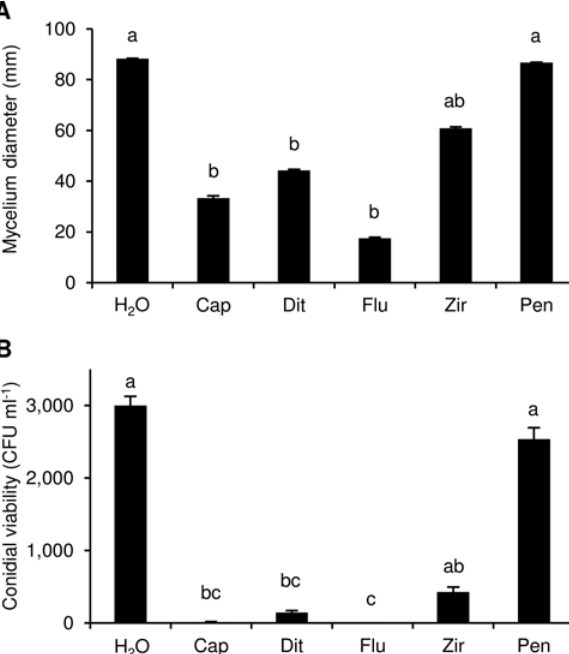
Figure 6. Disease severity a) caused by Diplodia seriata S and amount of pathogen DNA for 3-y-old trunks of apple plants inoculated with a mycelium plugs (black) or conidium suspensions (white) 60 d after incubation under greenhouse conditions. Plants were treated with water 1 d before inoculation (H 2 O) or with dithianon 7 d before inoculation (Dit -7), 1 d before inoculation (Dit -1), 1 d after inocu- lation (Dit +1) or 7 d after inoculation (Dit +7). Kruskal-Wallis test showed no significant differences between the two experiments ( P > 0.05, n = five replicates per experiment), and data from the two experiments were pooled. Means and standard errors for ten rep- licates (plants) from the two experiments are shown for each plant organ and inoculation procedure. No significant differences among treatments of mycelium plug- or conidium suspension-inoculated plants were found (Kruskal-Wallis test; P > 0.05).